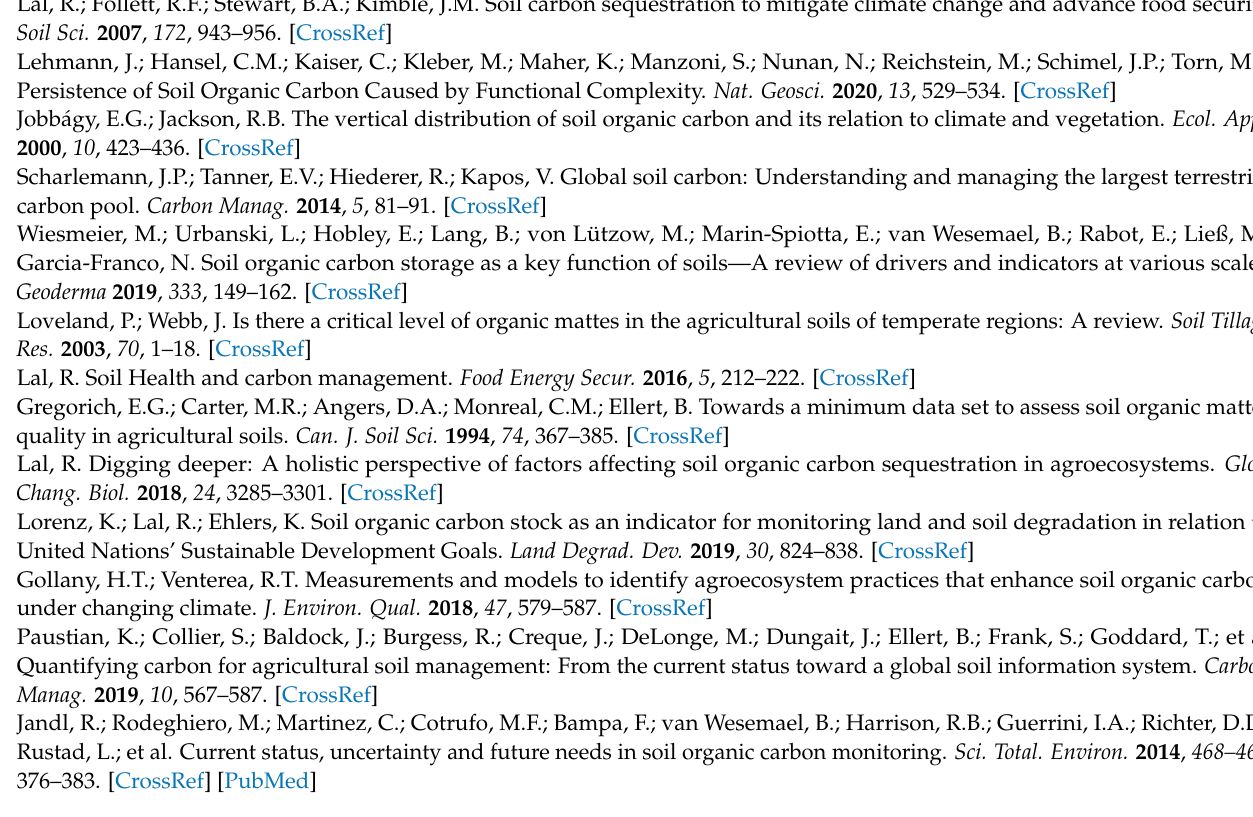
Figure A3. Autocorrelation of the prediction residuals of the model validation (30% of data points).